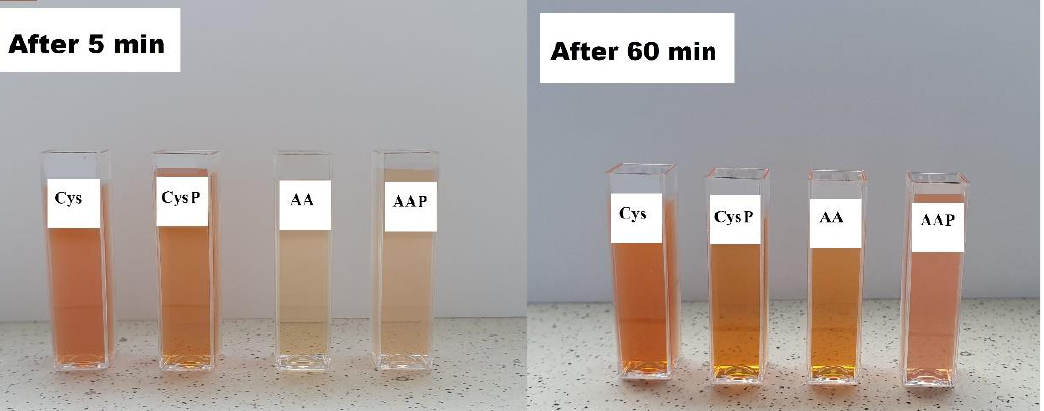
Figure 1. Color changes of product solutions upon synthesis of SeNPs (CysP or AAP — reductant in the presence of PVA).